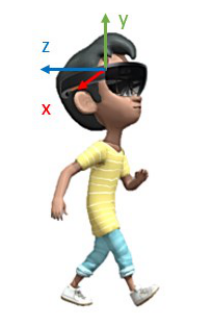
Figure 1. Spatial coordinate system of the AR HMD is (0; (cid:126) x ; (cid:126) y ; (cid:126) z ). The data acquisition rate was 100 Hz. At each frame, HoloStep calculates: Time (s), Position ( x H , y H , z H ) (m), Filtered position ( x F , y F , z F ) (m), Step detected ( Boolean ),